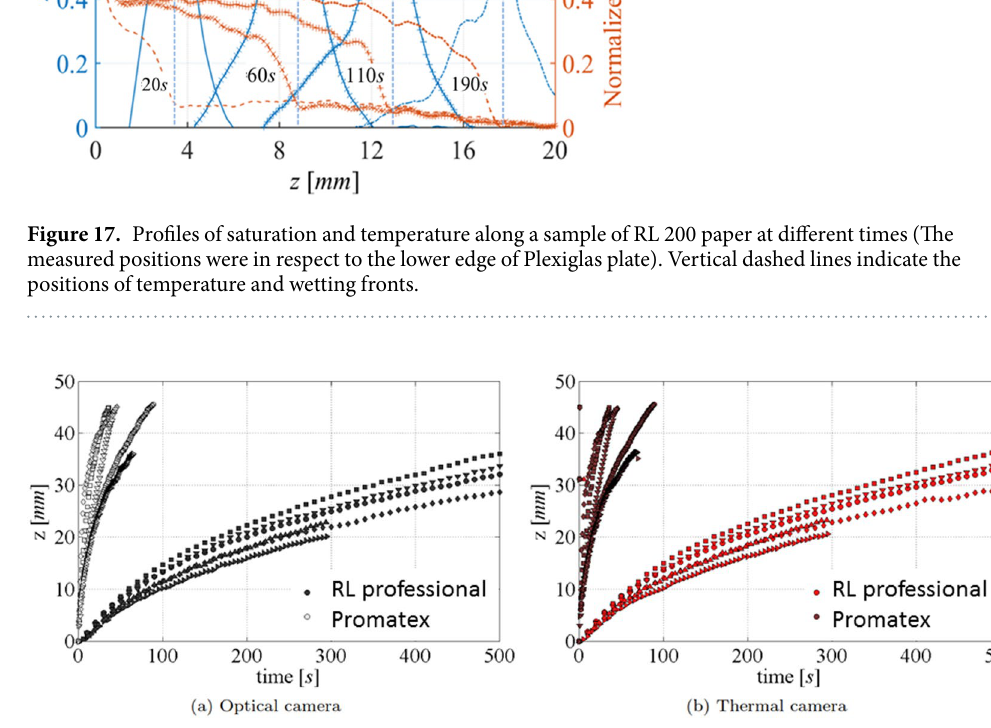
Figure 18. Imbibition height as a function of time for the optical and thermal